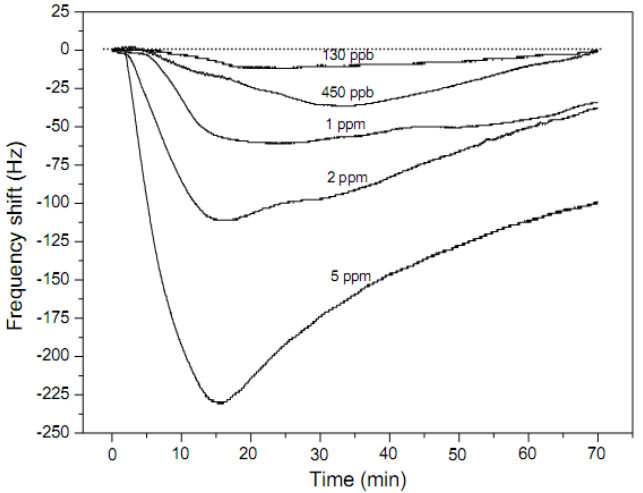
Figure 4. Response of the fibers coated QCM sensors with 10,000 Hz coating load exposed to various concentration of ammonia. The PAA fibrous membrane was obtained O and the relative humidity was 40% (reproduced with permission from the solvent of H 2 from ref.